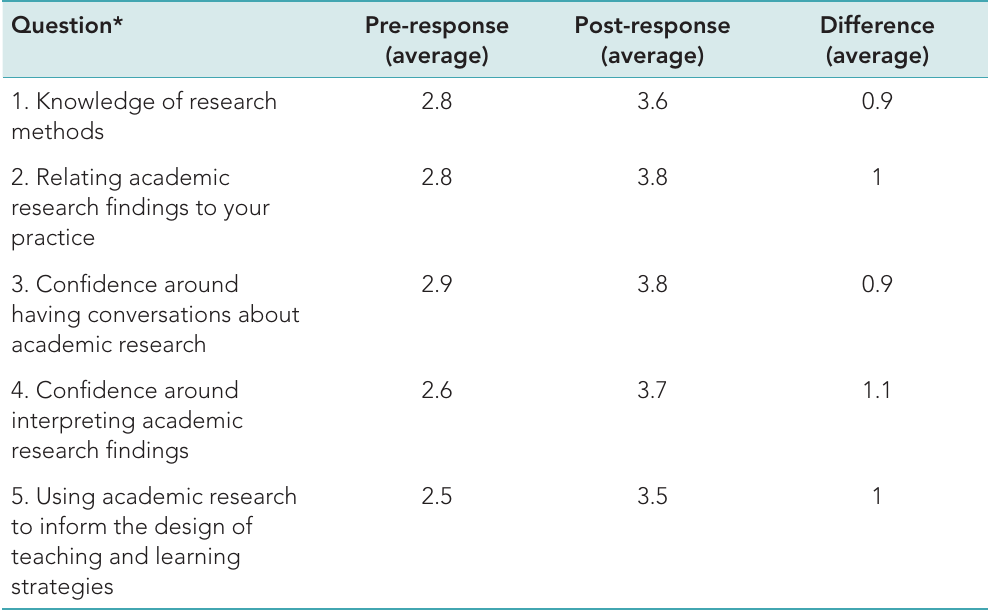
Table 1: Pre- and post-survey questions and responses (n=13)